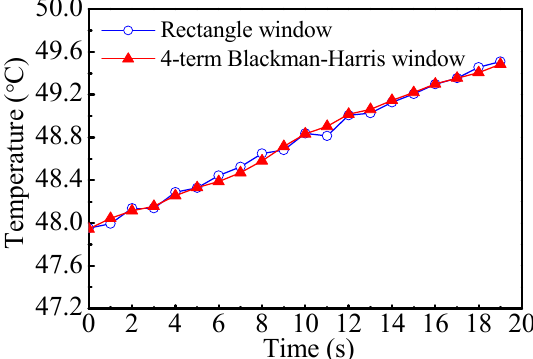
Figure 28. Temperature signals filtered by rectangle and four-term Blackman-Harris windowed average method.